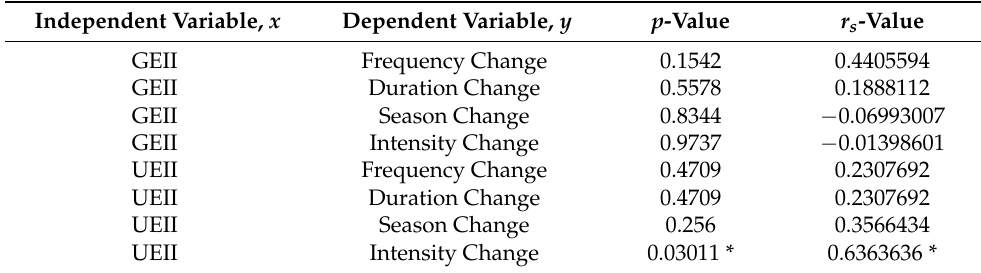
Table 13. Spearman correlation between UEII, GEII, and heatwave frequency, duration, season, and intensity for 12 cities in the West